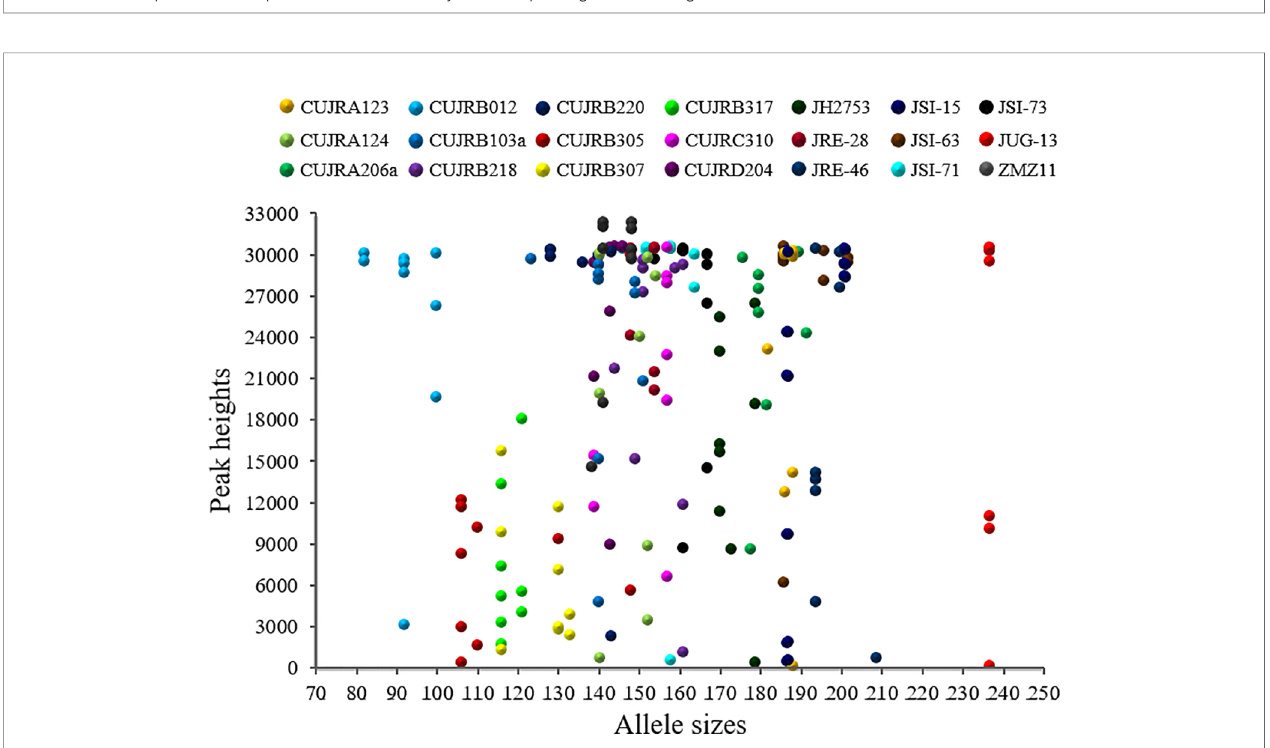
FIGURE 6 | Scatter diagram of 21 SSR loci detected in the nine walnut cultivars. The SSR loci are represented by different colors and symbols. The x-axis indicates allele size, while the y-axis indicates relative peak height. The allele sizes ranged from 82 to 237 nucleotides, while the relative peak heights ranged from 201 to 32,722.